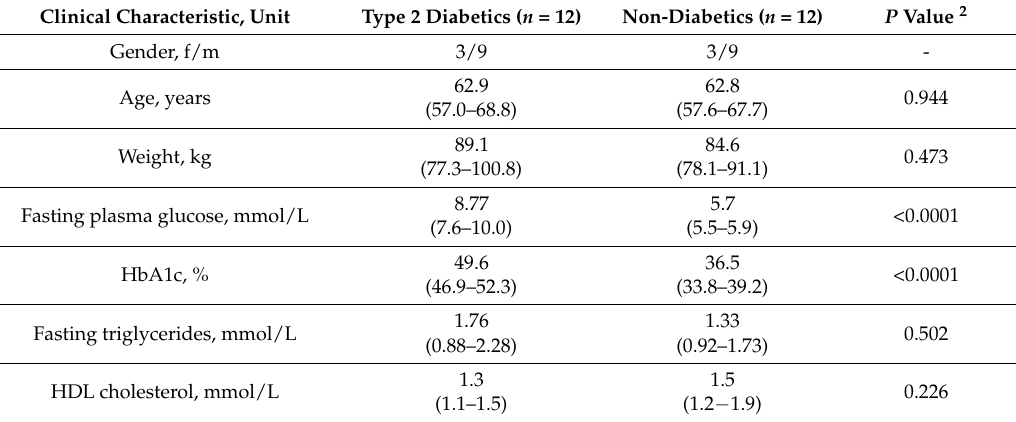
Table 1. Clinical characteristics. 24 subjects divided into two groups—type 2 diabetics and non-diabetics 1 . Clinical Characteristic,